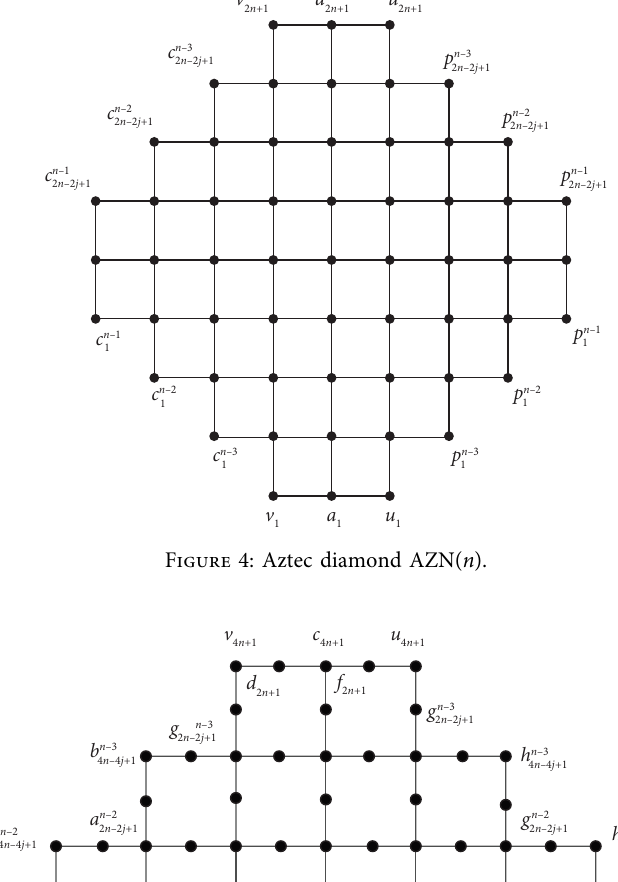
Figure 4: Aztec diamond AZN( n